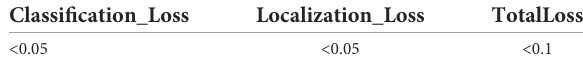
TABLE 2 Kitti-Trained models (ResNet101) training loss value.